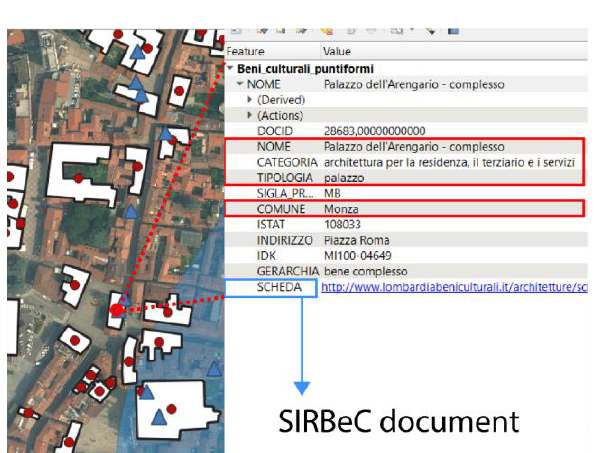
Figure 2. The attribute table of the point features describes cultural heritage. Extracted values are marked in red, and in blue is the hyperlink to access ‘SIRBeC’ documents online.